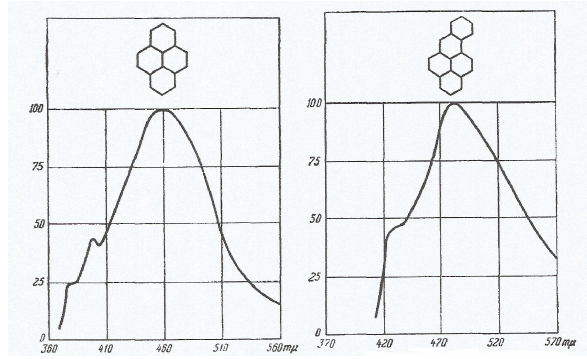
Figure 3. Spectra of photoluminescence of Pyrene and 3-4 Ben- zpyrene (Shpolskii